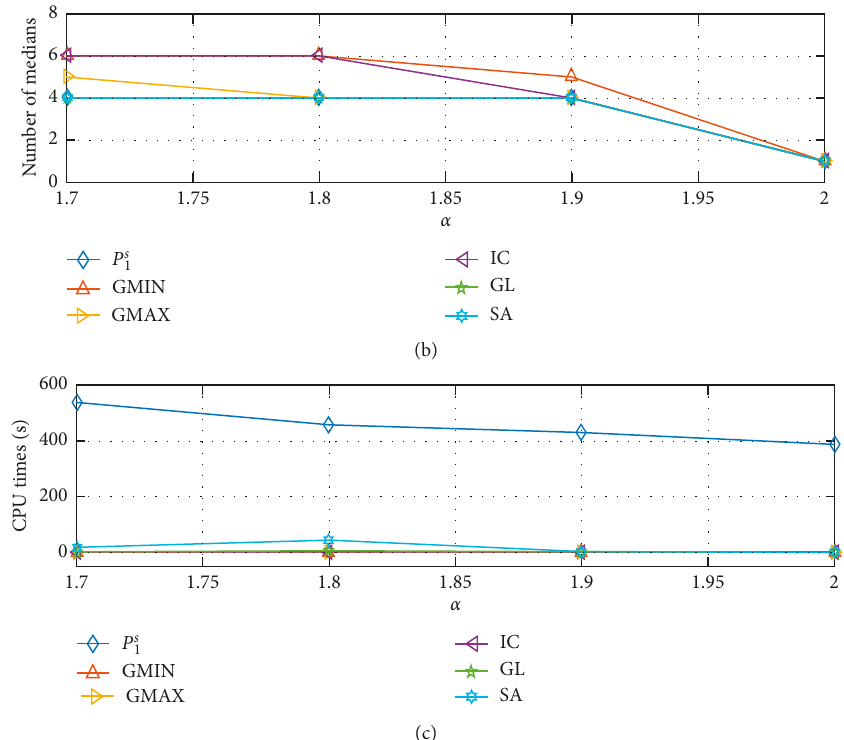
Figure 5: (a) Upper bounds and optimal solutions, (b) number of facilities, and (c) CPU times in seconds for the instance #11 in Table 1 while varying α ∈ [ 1 . 7 ; 2 ] and using a radial coverage value of